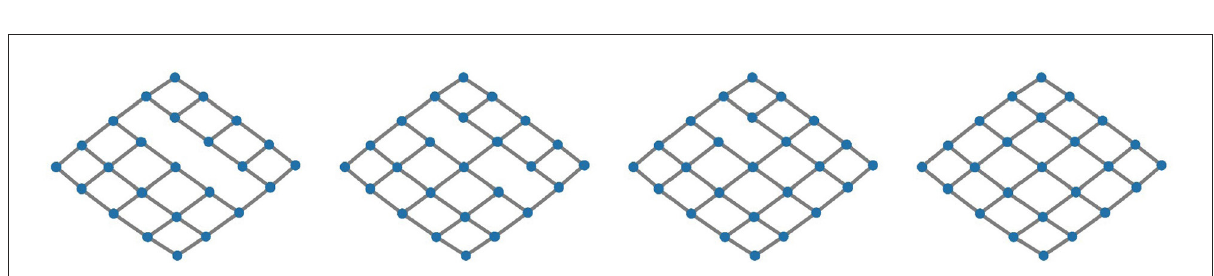
FIGURE4 Trajectory-based cascading spread model illustration (yellow: infected edge; green: travel path).